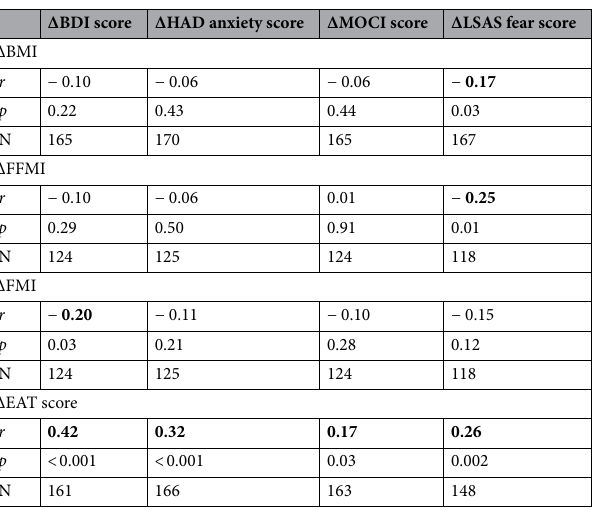
Table 4. Longitudinal analyses: correlations between change scores for nutritional markers and change scores for psychopathological measures during hospitalization. Bold: Significant associations. BDI Beck’s Depression Inventory, HAD Hospital Anxiety and Depression scale, MOCI Maudsley Obsessive–Compulsive Inventory, LSAS Liebowitz Social Anxiety Scale, BMI Body Mass Index, EAT Eating Attitude Test, FFMI fat-free mass index, FMI fat mass index, ∆ score change scores (admission minus